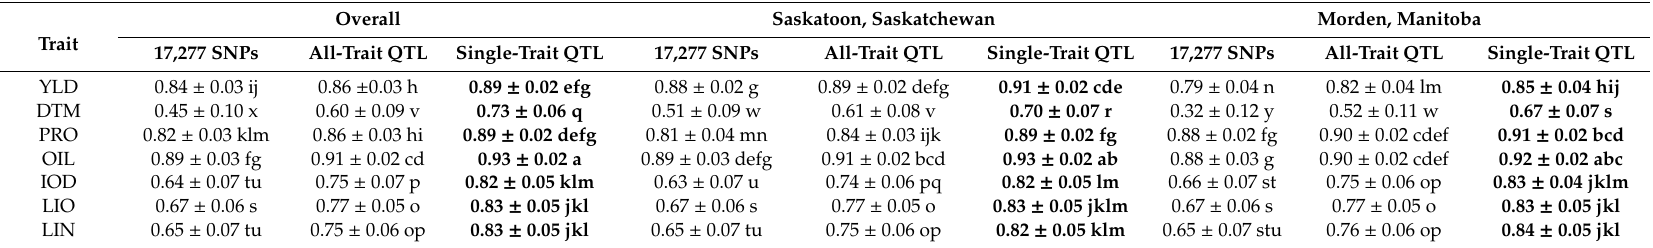
Table 5. Genomic prediction accuracy ( r ± s ) of seven traits a ff ected by di ff erent